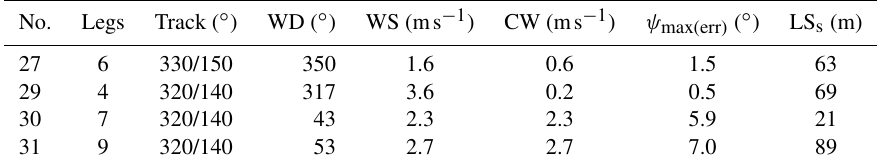
Figure 9. Average spectra for the u (left panel), v (middle panel) and w (right panel) components of the wind from SUMO (black) and the sonic anemometer from the 60m tower (blue), for all legs of flight no. 29. The − 5 / 3 line (dashed gray) indicates the inertial subrange of the spectra. Table 2. SUMO turbulence transects near the 60m tower. Wind direction (WD), wind speed (WS) and the crosswind (CW) component are based on 10min average values from the sonic anemometer mounted at 60m. The maximum error in ψ ( ψ max(err) ) is estimated based on the airspeed from SUMO and the CW. The integral length scales for the sonic at 60m (LS s ) are calculated using horizontal wind speed over 10min averaging